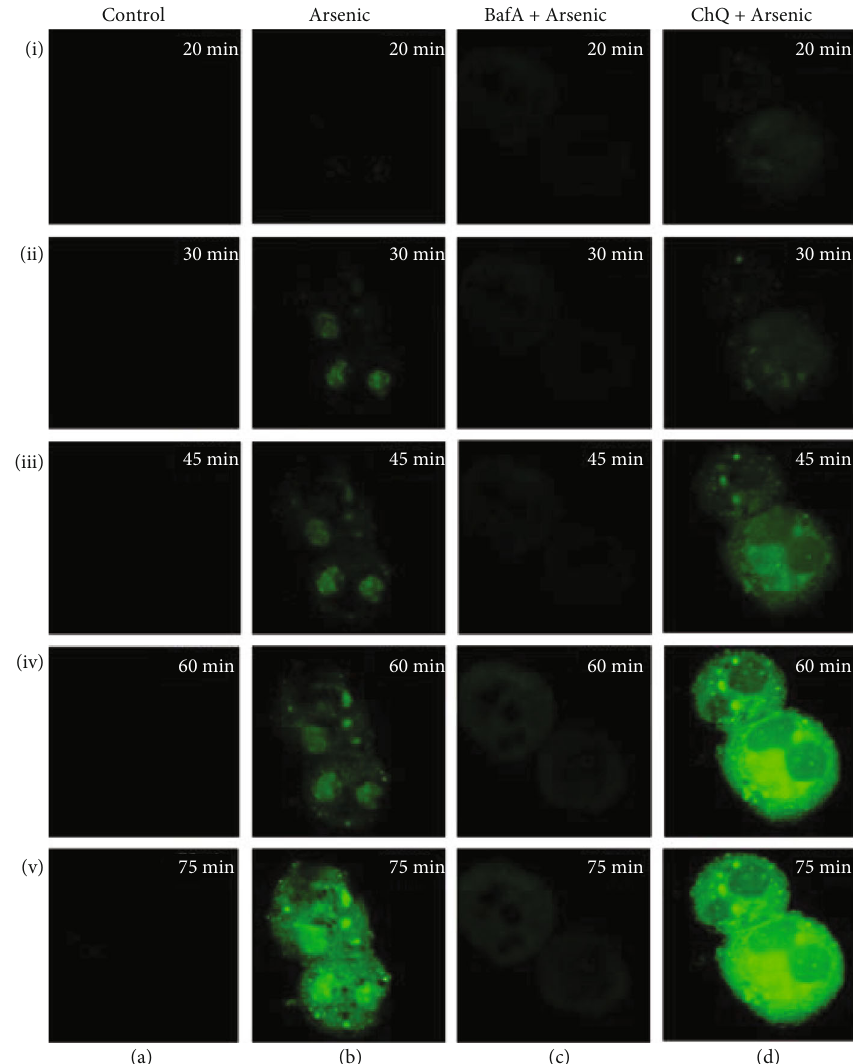
Figure 3: Alteration of arsenic-induced LMP evaluated by increase in green fl uorescence as observed by confocal microscope using AO relocation technique in presence or absence of LMP inducer (BafA) and inhibitor (ChQ) at di ff erent time intervals. Control (a) and arsenic (b) exposed primary cultured mouse hepatocytes were preincubated with or without BafA (c) and ChQ (d) (magni fi cation of all the fi gures are 40x). The fi gure is representative photomicrographs of 3 independent experiments. LMP was not observed in control hepatocytes since no signi fi cant green fl uorescence was noted from 20 min to 75min (ia-va). Arsenic exposure of mouse hepatocytes